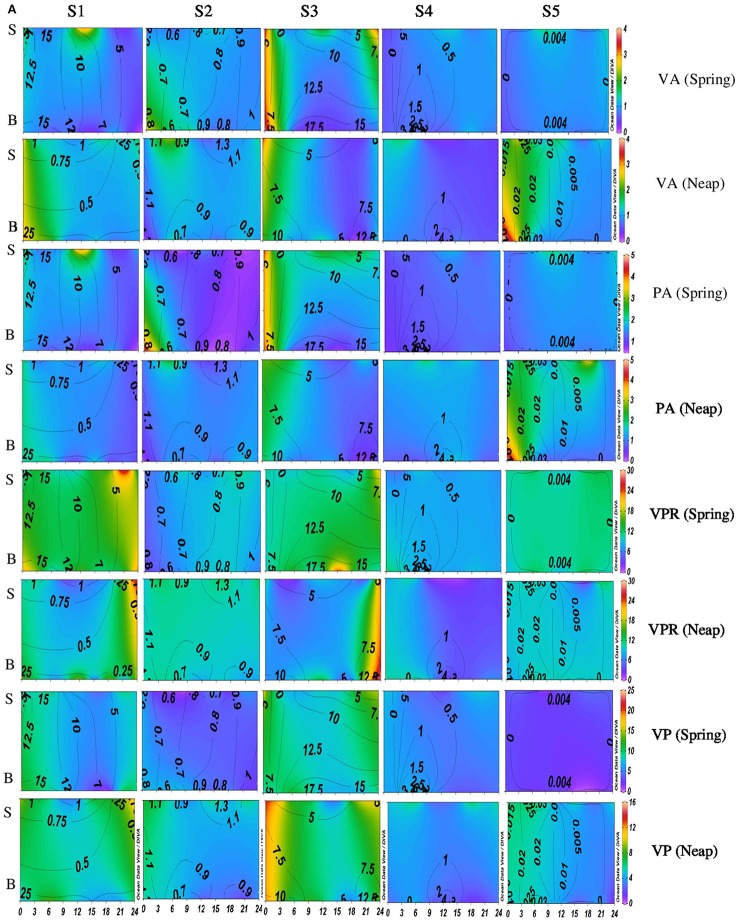
Temporal variations (diel and tidal) in biological parameters during monsoon (MON) in CE. X- axis represents the time series observations from 00:00 to 24:00 h and Y-axis represent the vertical section of the water column (S, Surface; B, Bottom). Z-axis represent different parameters in color contours and salinity is superimposed as the line contours. The vertical panels S1, S2, S3, S4, and S5 represents the five stations. The horizontal panels represent various parameters during MON, such as viral abundance (VA) (106 VLPs mL−1), prokaryotic abundance (PA) (106 Cells mL−1), virus-to-prokaryote ratio (VPR), and viral production (VP) (1010 VLPs L−1day−1), during spring and neap phases separately.